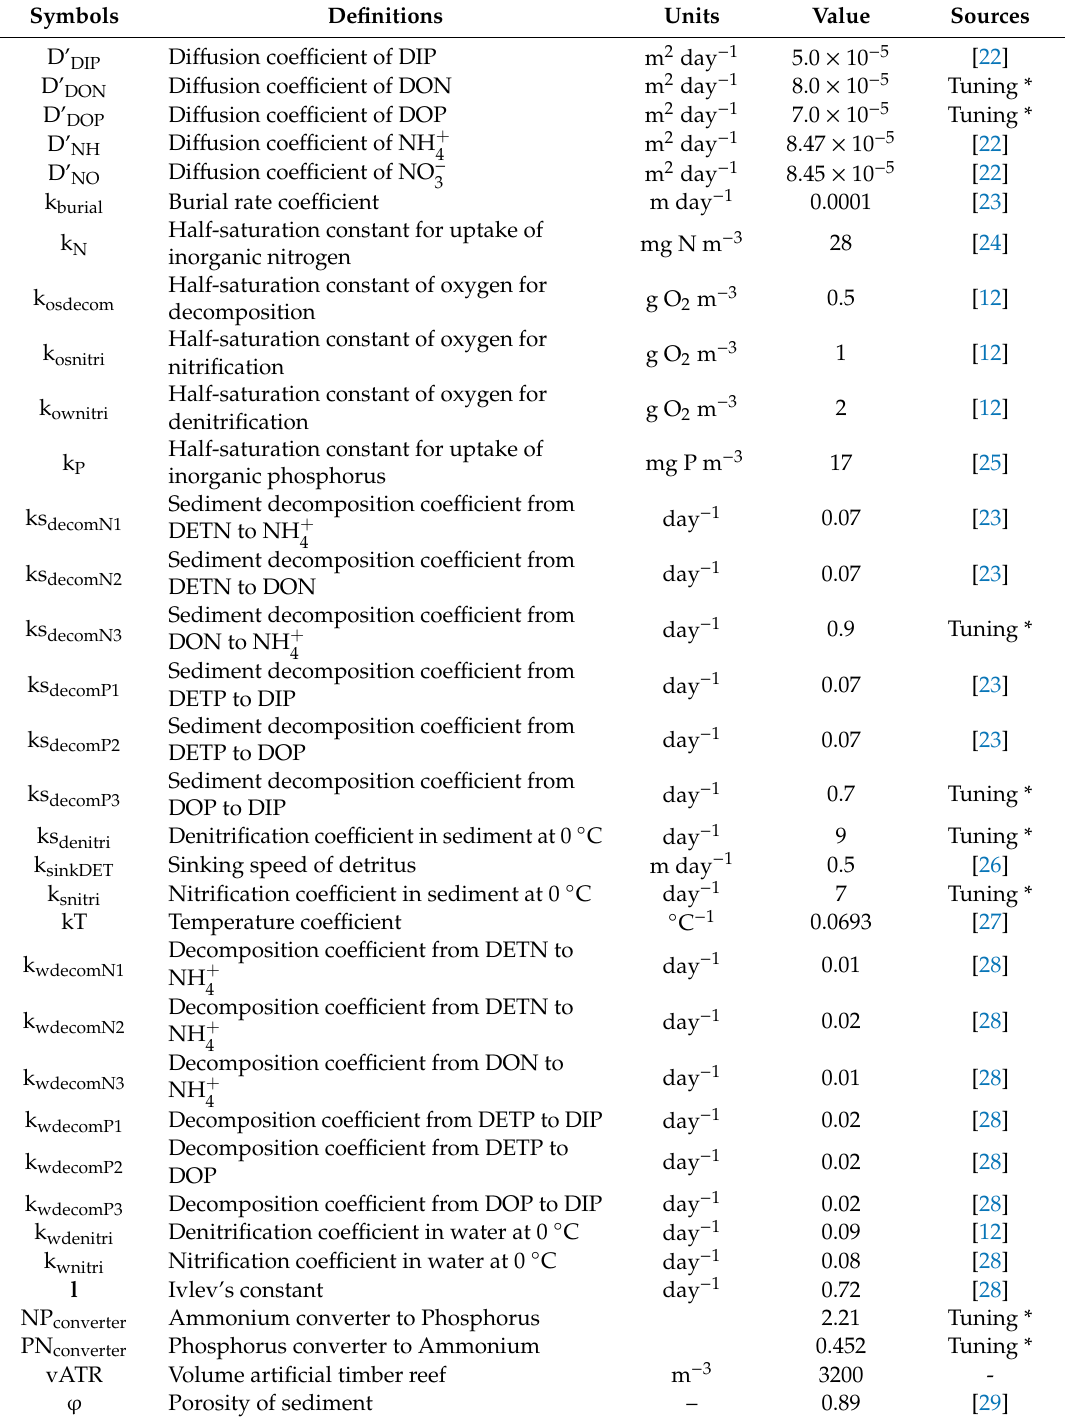
Table 1. List of the parameters used in the